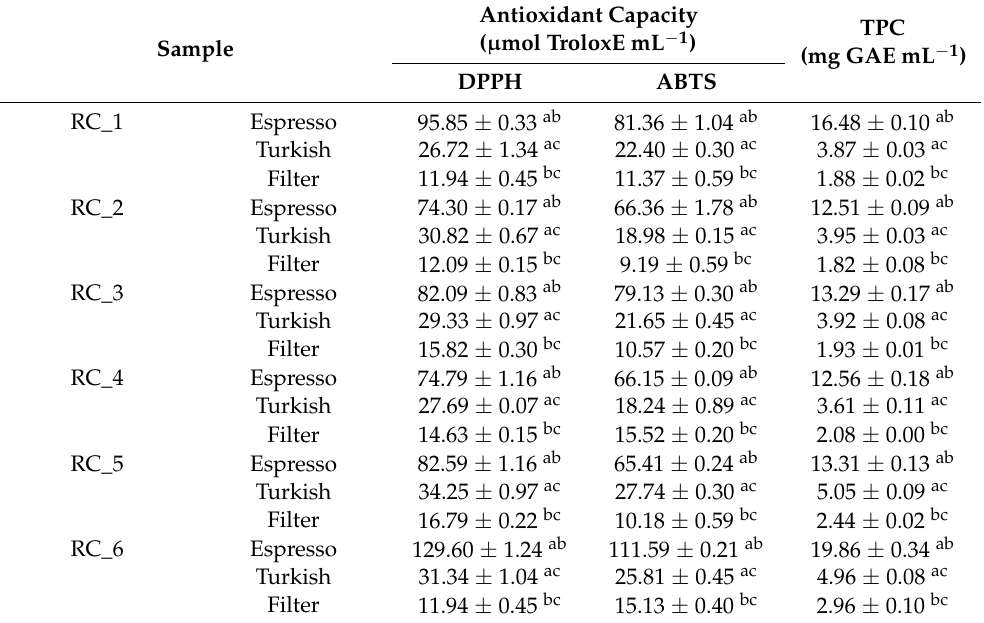
Table 5. Antioxidant capacity and total phenolic content (TPC) of differently prepared coffee brews.